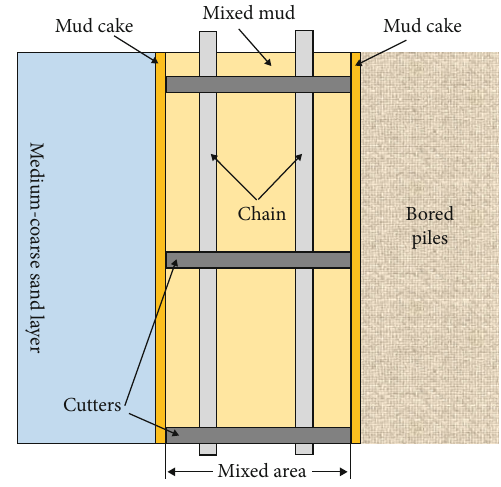
Figure 4: Schematic diagram of mixing and mud cake